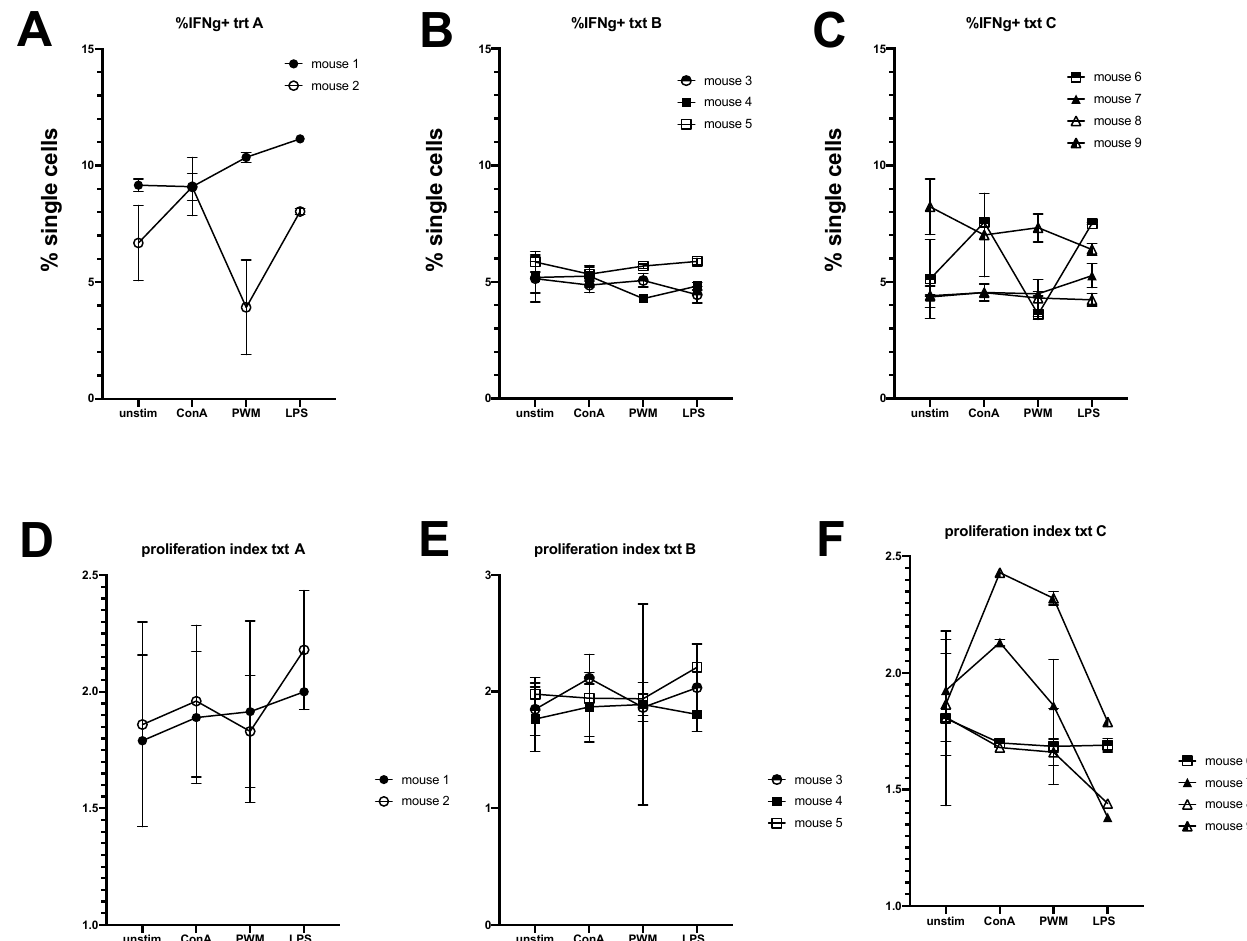
Figure 5. Assessment of functional capacity of transferred equine bone marrow cells retrieved from host spleens 56 days post-engraftment. Splenic cells were labelled with CFSE and cultured for 48 hours under different stimulants – ConA, PWM, and LPS. ( A , B , C ) Interferon-positive cell percentages were assessed for the three different treatment groups. ( D , E , F ) Proliferation index based on CFSE fluorescence was assessed for the three different treatment groups.